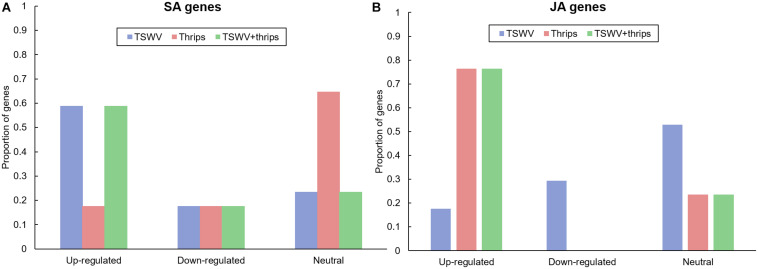
Proportion of differentially-expressed genes in the (A) salicylic acid (SA) and (B) jasmonic acid (JA) pathway in response to TSWV infection alone, F. occidentalis alone, and the combined treatment. n = 17 possible SA genes, n = 17 possible JA genes represented on the array. The list of SA and JA genes and the average normalized hybridization values are provided in Supplementary Table 4.